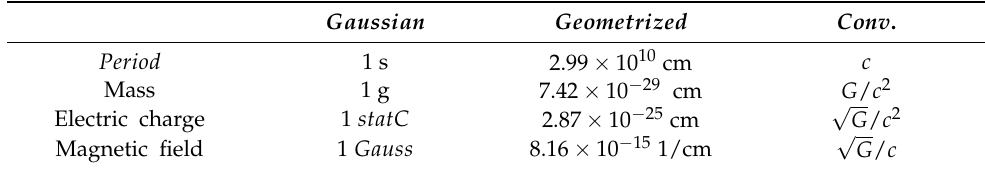
Table A1. Units and conversions in Gaussian and geometrized systems.